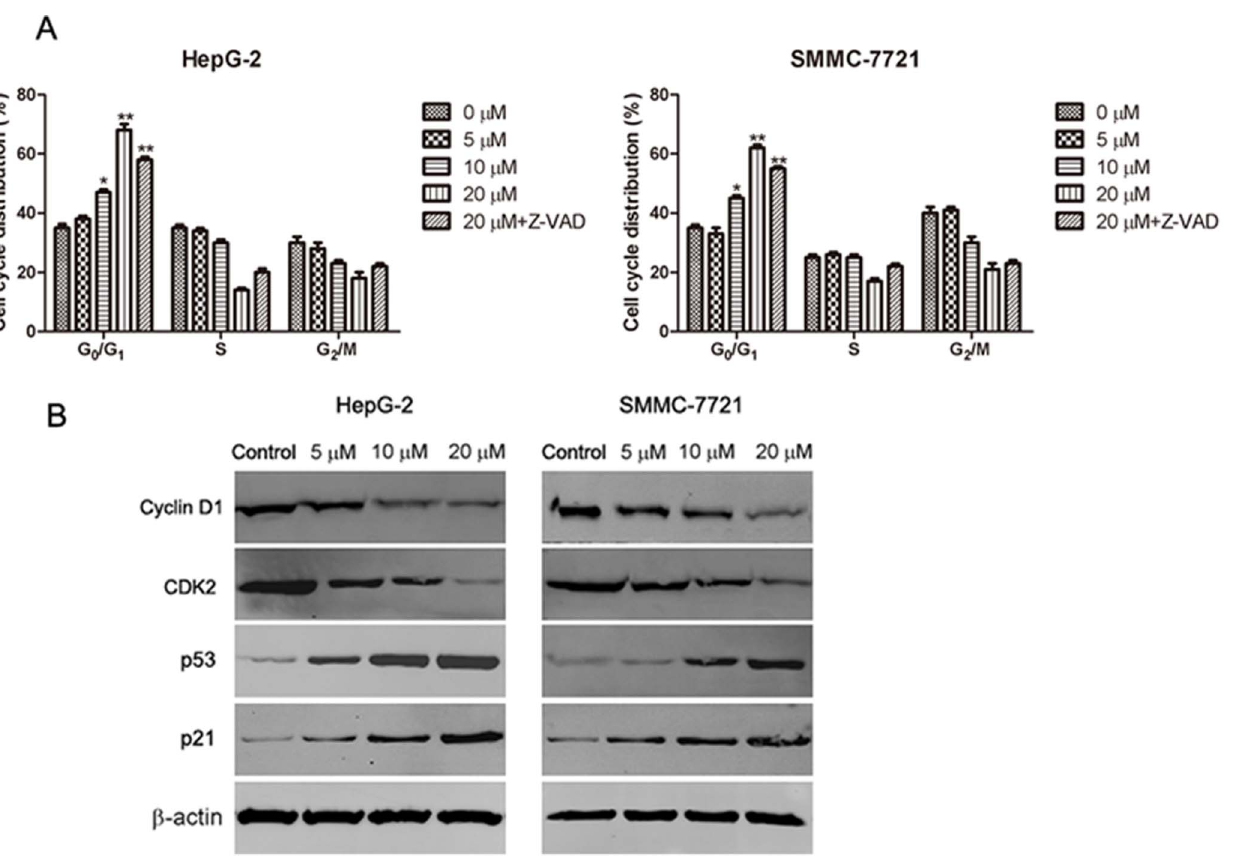
Fig. 4. The effect of abieslactone on the cell cycle and the expression of cell cycle regulators in HepG2 and SMMC7721 cells. (A) Abieslactone treatment induced a dose dependent increase in the proportion of cells in the G 1 phase and a decrease in cells in the S and G 2 phases compared to the untreated control. Z-VAD-FMK treatment did not prevent cell cycle arrest following high-dose abieslactone treatment. The results are represented as the mean ¡ SEM for three independent experiments with similar results. * P , 0.05; ** P , 0.01 vs . the untreated control. (B) Representative pictures for p53, p21 CDK2 and cyclin D1 protein expression by western blot analysis. b -actin was used as a control.